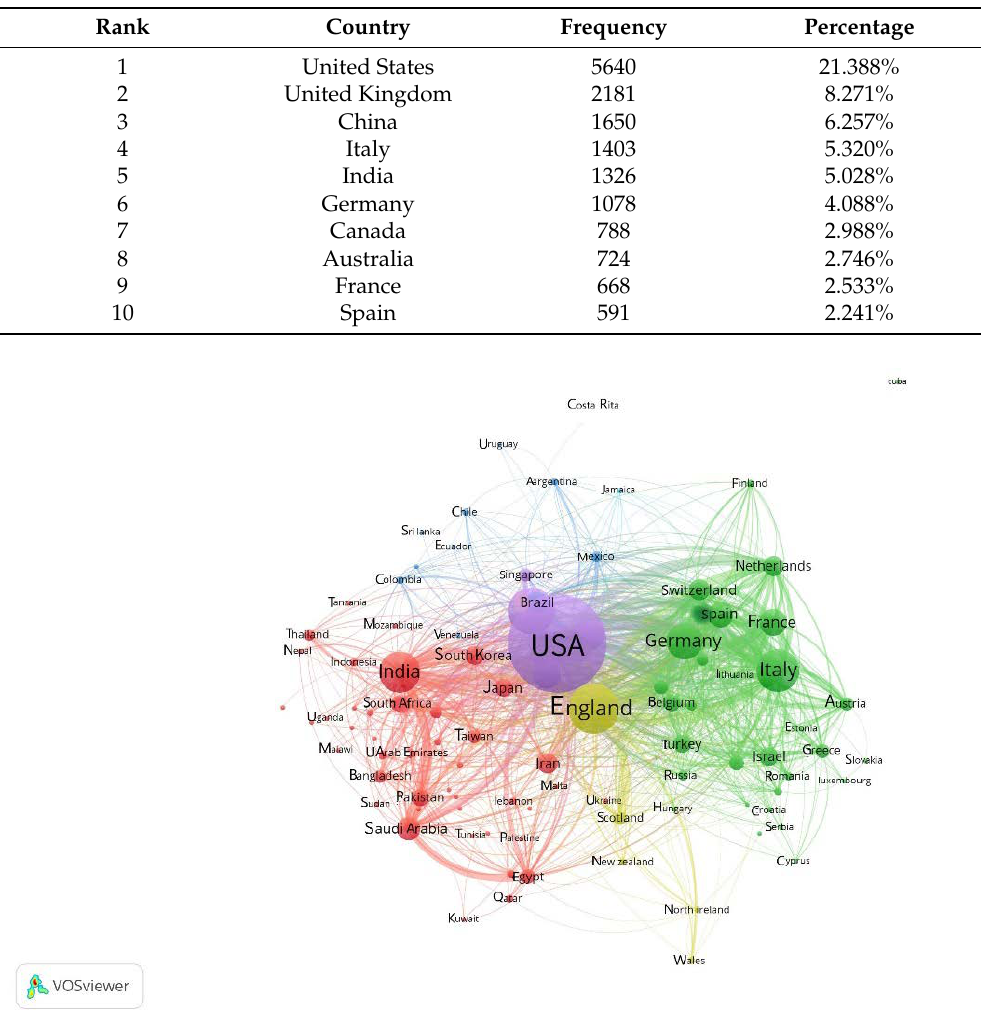
Figure 7. The cooperation chart of the countries for journals publishing research papers on COVID-19, using network visualization through VOSviewer.